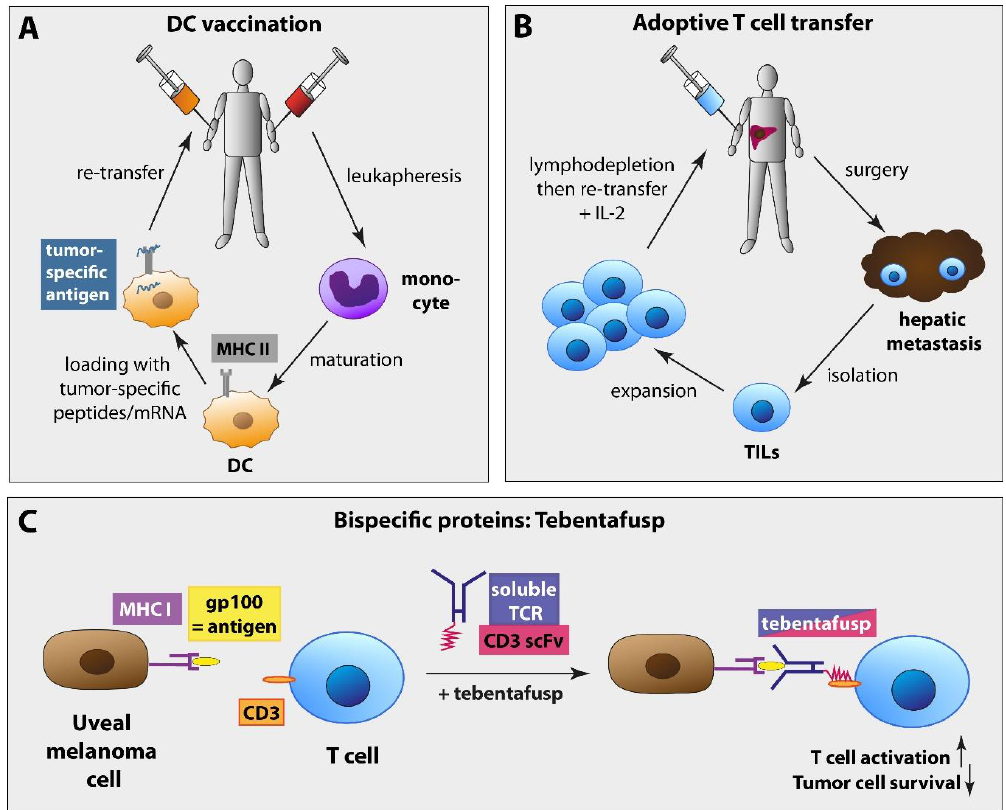
Figure 2. Promising future immunotherapy options for UM patients. ( A ) Dendritic cell vaccination: Monocytes or other hematopoietic progenitors are isolated from the tumor patient via leukapheresis and develop in vitro in the presence of stimulatory cytokines to mature DCs. These are then loaded with tumor-specific peptides (i.e., gp100, tyrosinase) or mRNA encoding these antigens and